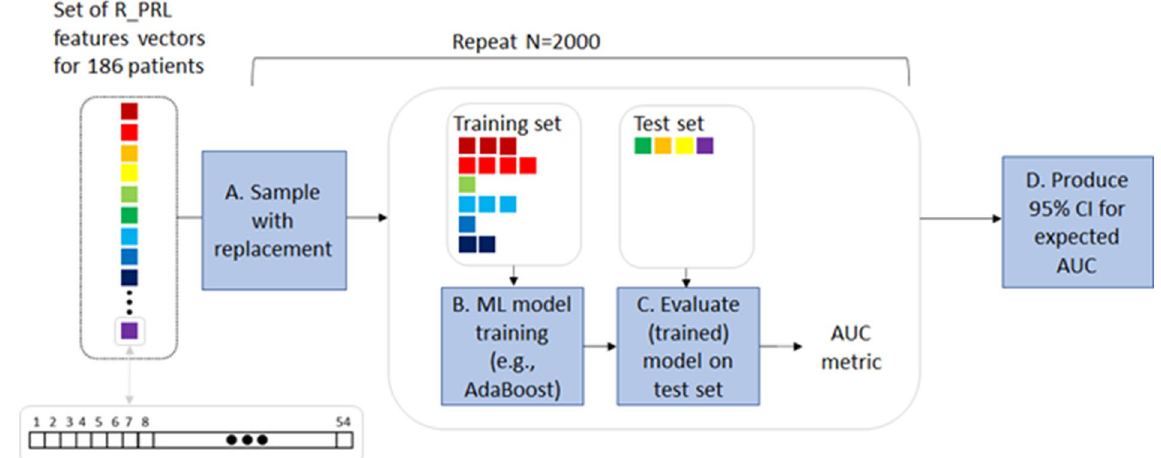
Figure 6. An illustration of producing a confidence interval (CI) for a single PLR parameter (in this case, R_PRL). Given the full set of samples, a training set was created by sampling with replacement, whereas the test set was comprised of all the samples that were not picked in the training set. The model was evaluated on the test set (average size of 88 distinct samples) using the AUC-ROC metric. The process was repeated N = 2000 times to infer a 95% CI. R_PRL Pupil Reflex Latency induced by red light, CI confidence interval, AUC-ROC Area Under the Receiver’s Operating